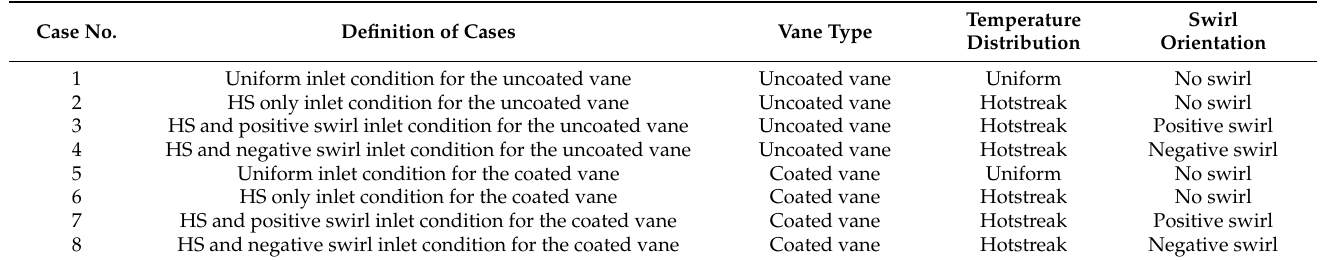
Table 1. Definition of the simulation cases.